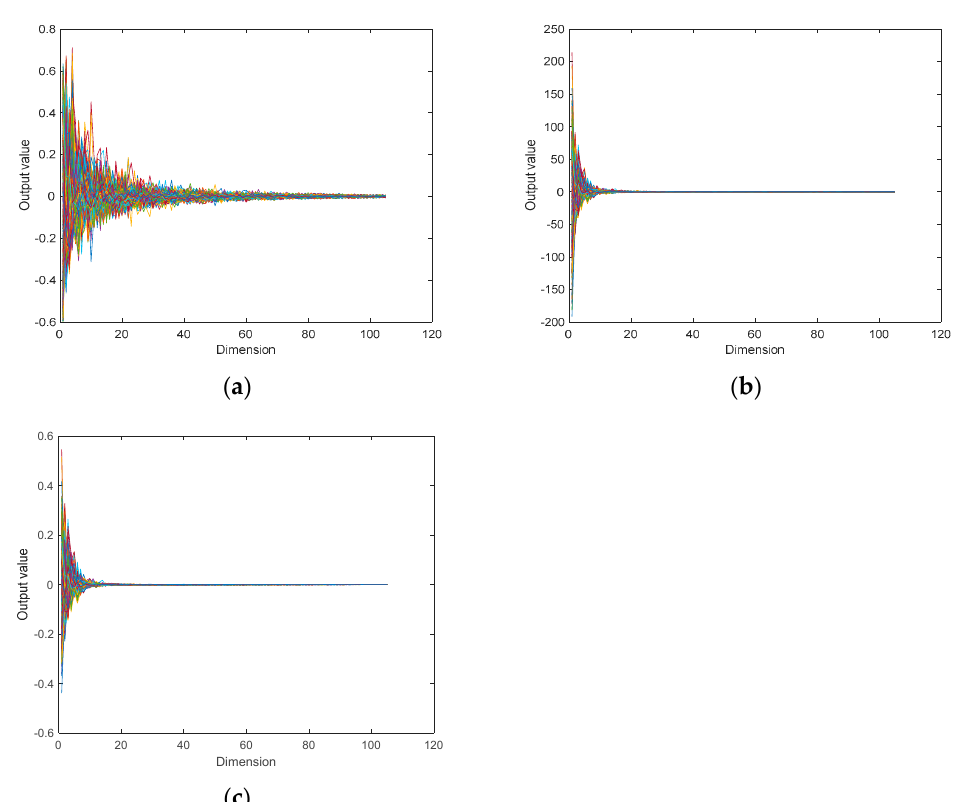
Figure 6. Comparison of the prediction results of the linear kernel function with other kernel functions in the kernel principal component analysis (KPCA) model. ( a ) radial basis function (RBF), ( b ) polynomial (Poly), and ( c ) linear.